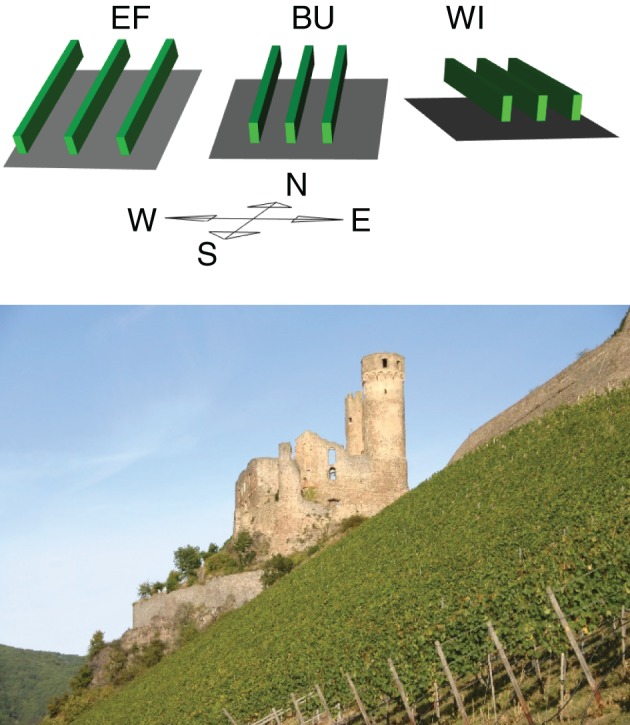
Upper part: Graphical outline of three experimental vineyards true to scale in row distance, canopy height and width, slope and aspect ratios. Green cuboids illustrate grapevine rows, soil is gray. Bottom part: The experimental vineyard EF with the castle ruin Ehrenfels in the background.